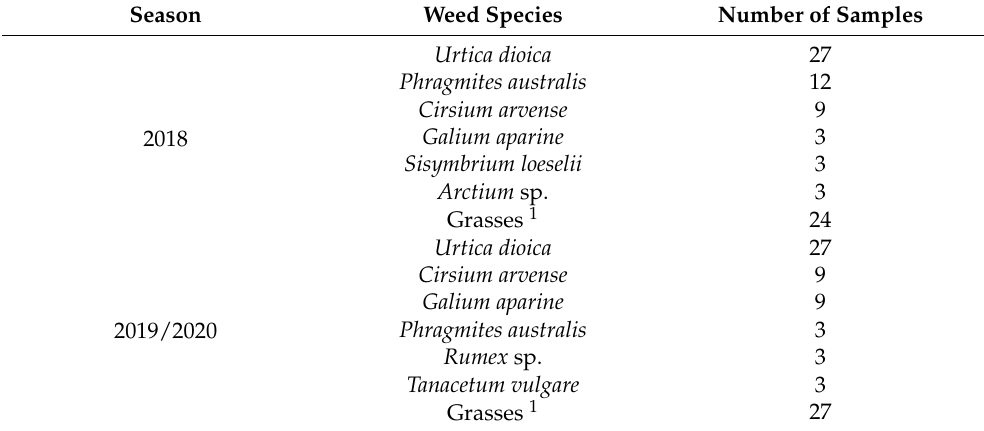
Figure 1. The location of the study region (AgroScapeLab Quillow) within the German national borders ( left ). Distribution fields with the kettle holes thereon, investigated in 2018 (red dots) and 2019/2020 (orange dots) within the AgroScapeLab Quillow region ( right ). An experimental infrastructure platform of the Leibniz Centre of Agricultural Landscape Research (ZALF) is located in Dedelow, Uckermark, State of Brandenburg, Germany. Table 1. Overview of the different sampled weed plant species growing at the edges of kettle holes in 2018 and 2019/2020 and the number of samples of each specific weed summarized for each year.